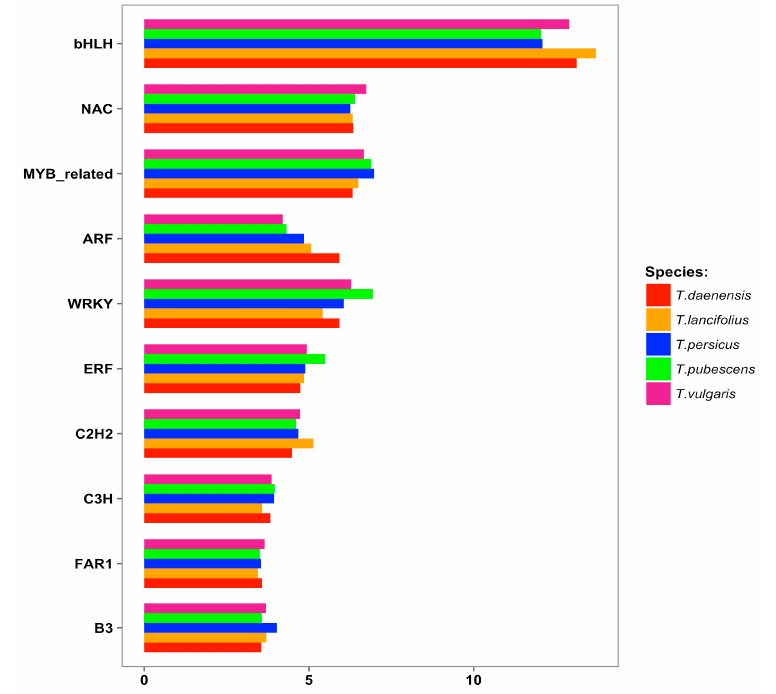
Figure 4. Distribution of transcripts in different transcription factor (TF) families showing over- representation in